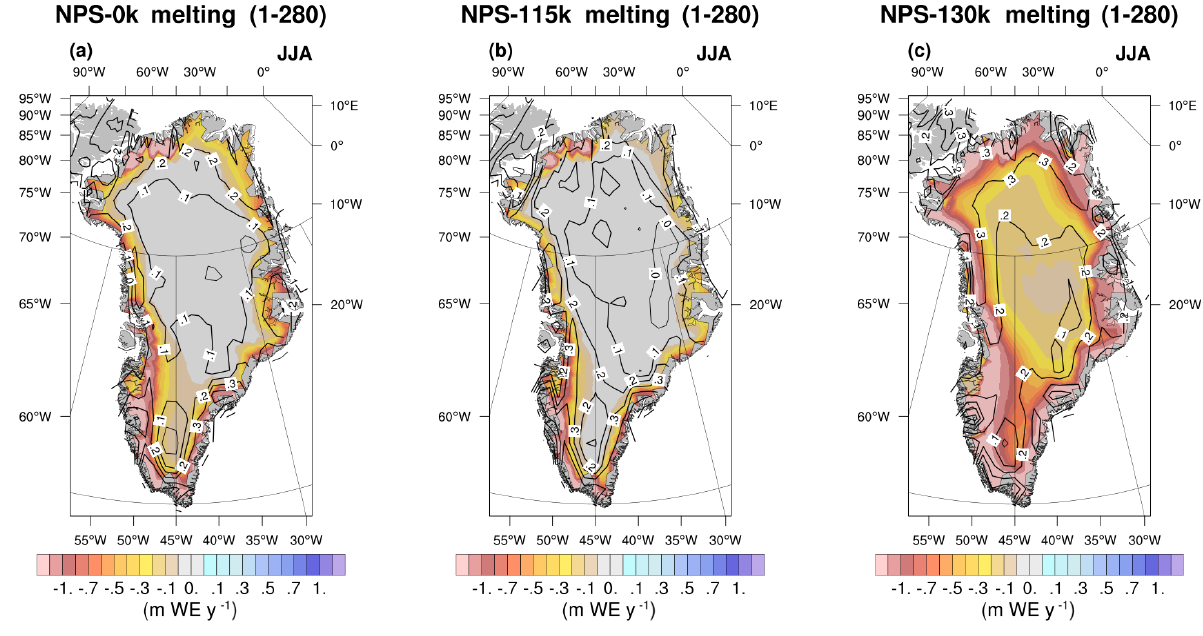
Figure 10. Summertime mean melting (in mWEyr − 1 ) and (superimposed) its correlation with the NAO index for (a) the preindustrial period, (b) 130ka and (c) 115ka.